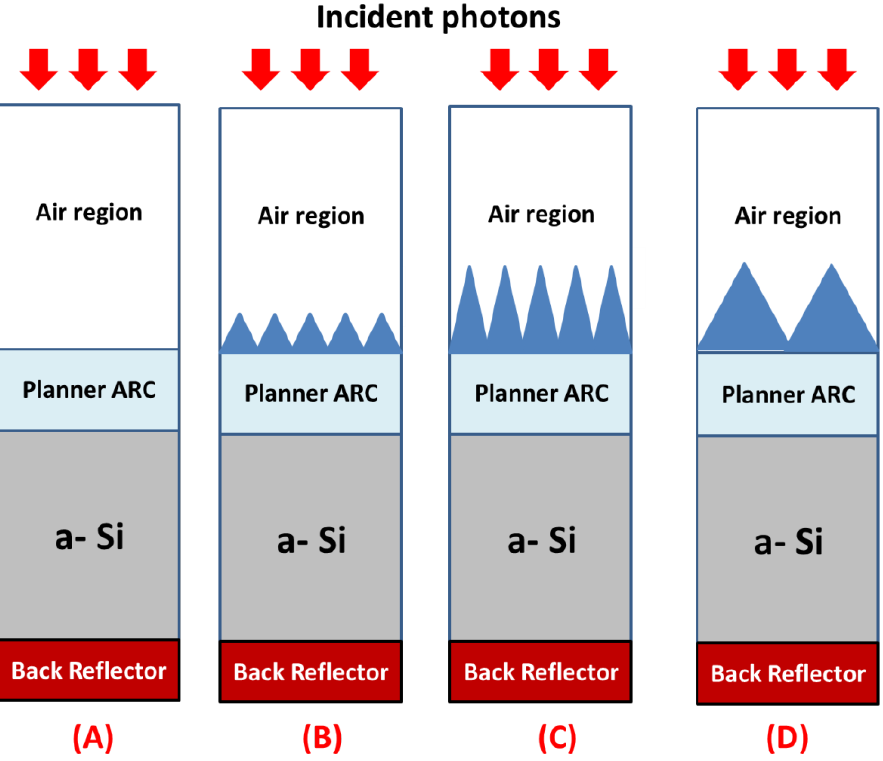
Figure 1. Schematic structure of amorphous silicon solar cell with different dimensions of texturing anti-reflection coating and back reflector with different shapes in ( A – D ).